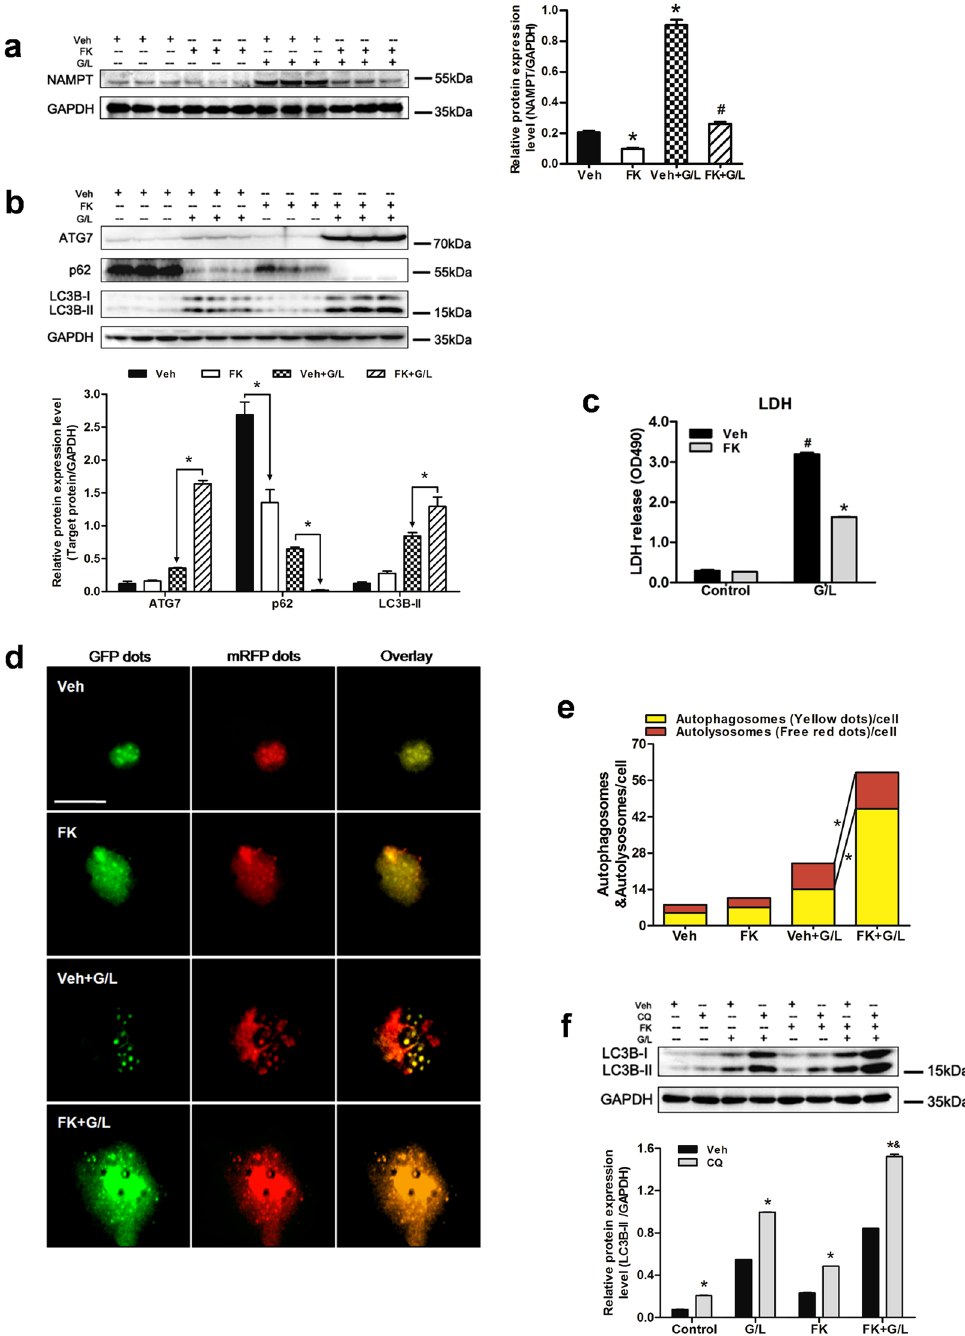
Figure 5. FK866 induces autophagy and alleviates hepatotoxicity induced by GaIN/LPS in primary hepatocytes. Hepatocytes were pretreated with either FK866 (FK, 100 nM, 30 min) or vehicle (Veh) and followed by GaIN/LPS (G/L, 1 mg/mL /30 ng/mL, 24 h) challenge. ( a ) Western blot analysis of NAMPT protein expression in the presence and absence of FK. The data are shown as the means ± SEM of three independent experiments performed in duplicate. * P < 0.05 compared to the Veh group, # P < 0.05 compared to the Veh + G/L group. ( b ) Measurement of ATG7, p62, and LC3B expression in the presence or absence of FK. The data are shown as the means ± SEM of three independent experiments. * P < 0.05 indicates significant differences. ( c ) Examination of LDH release of primary hepatocytes. The data are shown as the means ± SEM of three independent experiments. * P < 0.05 vs. corresponding Veh group, # P < 0.05 vs. the corresponding control group. ( d ) Representative fluorescence micrographs showed autophagy vacuoles in hepatocytes with G/L in the presence or absence of FK from a pool of at least 10 images. Original magnification × 200, scale bar 50 µ m. ( e ) Quantification of autophagosomes and autolysosomes. * P < 0.05. ( f ) Western blot analysis of LC3B protein expression in the presence and absence of chloroquine (CQ). The data are shown as the means ± SEM of three independent experiments. * P < 0.05 vs. the corresponding Veh group, & P < 0.05 vs. the CQ + G/L